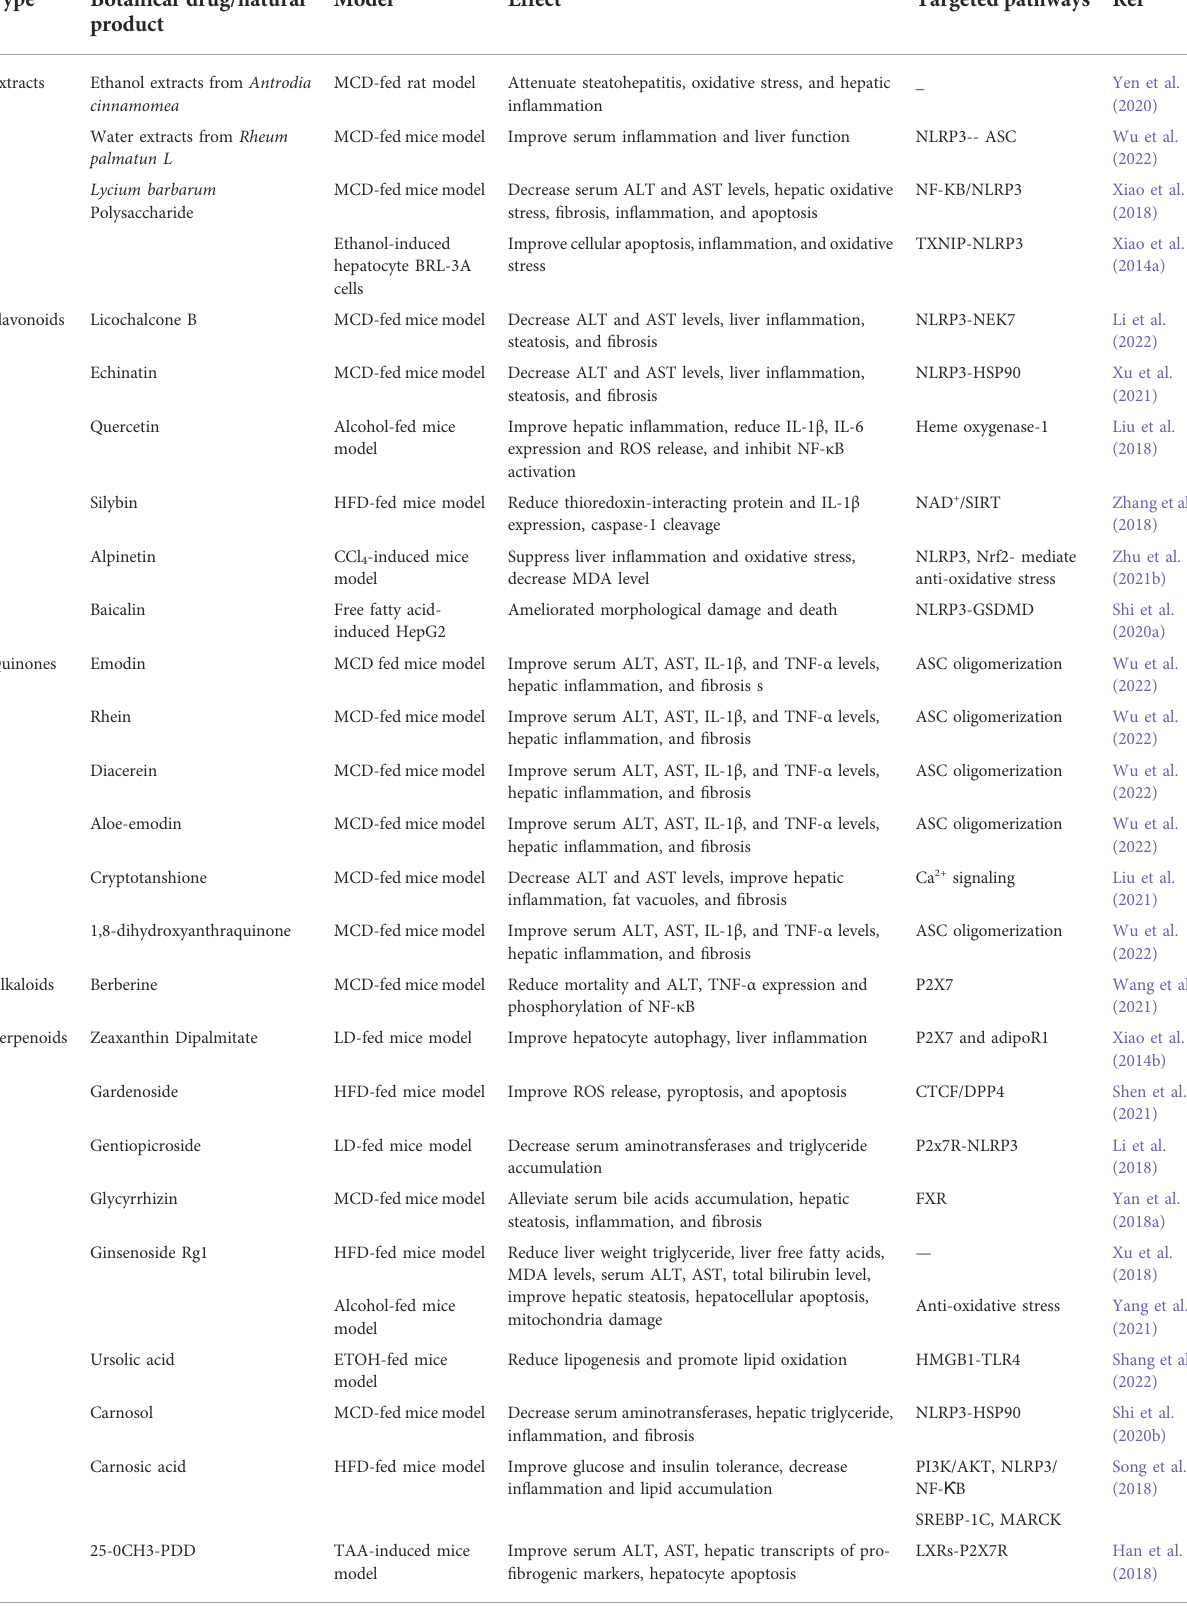
TABLE 4 Botanical drugs and natural products for the treatment of FLD by inhibiting NLRP3 in fl ammasome